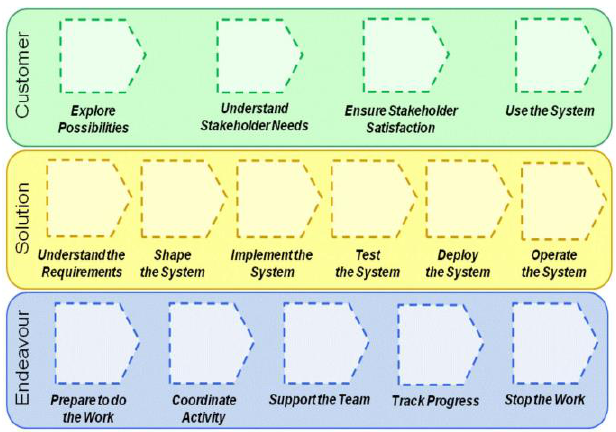
Fig. 2. Activity Spaces against area of concerns